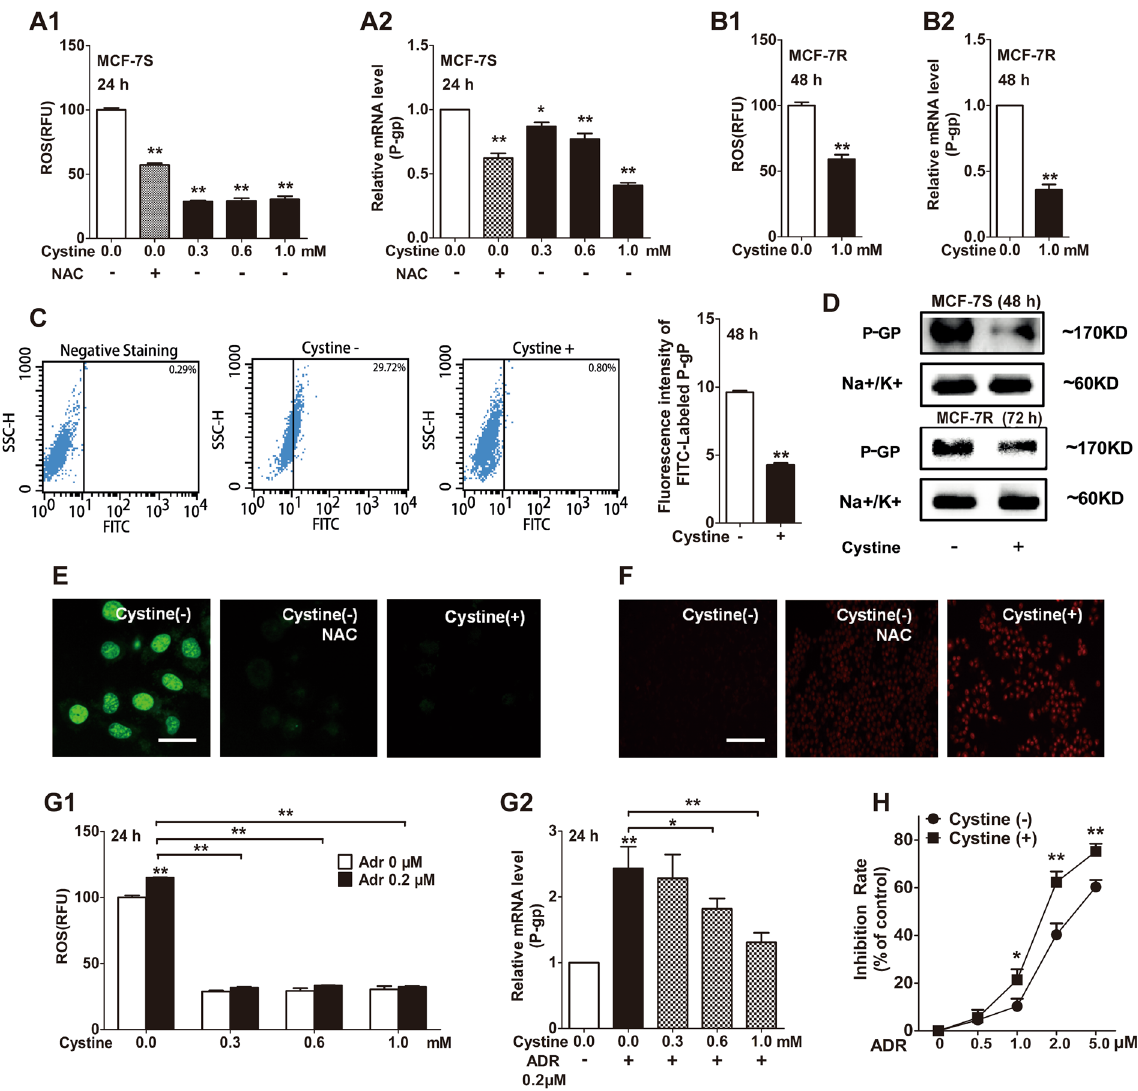
Figure 5. Deprivation and sufficient supplementation of cystine positively or negatively affected P-gp expression in MCF-7S and MCF-7R cells, respectively. ( A ) Additional cystine reduced ROS levels and P-gp mRNA expression in MCF-7S cells, similar to NAC (10 mM, 12 h). ( B ) Additional cystine reduced ROS levels and P-gp mRNA expression in MCF-7R cells. ( C ) Additional cystine (1.0 mM) decreased P-gp protein expression in MCF-7S cells, as shown via flow cytometry analysis and quantified according to mean fluorescence intensity. ( D ) Additional cystine (1.0 mM) reduced P-gp protein expression in MCF-7S and MCF-7R cells, as shown by Western blot. ( E ) Sufficient supplementary cystine (1.0 mM, 48 h) efficiently reduced P-gp protein expression, as did NAC (10 mM, 24 h), as shown by laser confocal scanning analysis. Scale bar: 20 μ m. ( F ) Sufficient supplementary cystine (1.0 mM, 72 h) even showed greater inhibition on the function of P-gp than the effect of NAC (10 mM, 24 h), as demonstrated via intracellular Rho 123 accumulation in MCF-7S cells. Scale bar: 100 μ m. ( G ) Additional cystine reversed the effects induced by ADR on MCF-7S cells, in terms of ROS levels and P-gp mRNA expression. ( H ) Additional cystine (1.0 mM, 72 h) heightened the cytotoxic sensitivity of ADR (24 h) on MCF-7S cells, as measured with the MTT assay. All experiments in this figure used cystine deprivation as a control and were conducted in triplicate. Data with error bars are presented as the mean ± SD (n = 3). * p < 0.05; ** p <